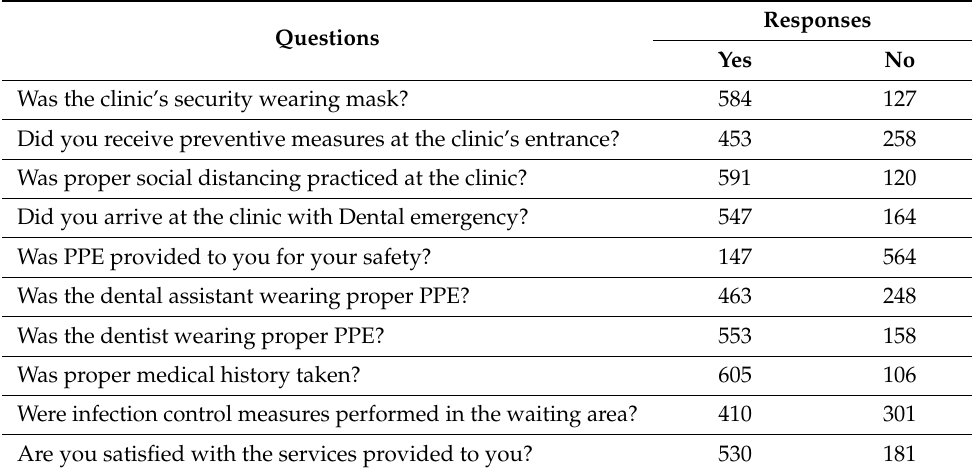
Table 2. Responses of the patients to assess their satisfaction.